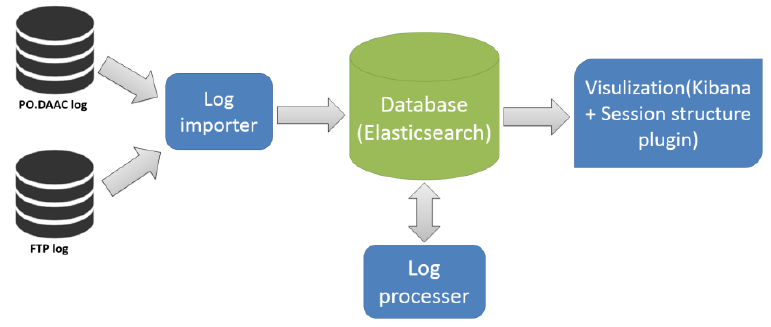
Figure 2. Session reconstruction system architecture.